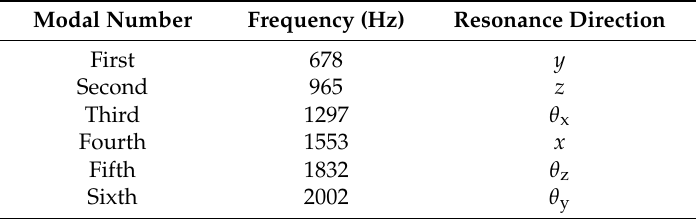
Table 2. FEM dynamic modal simulations.